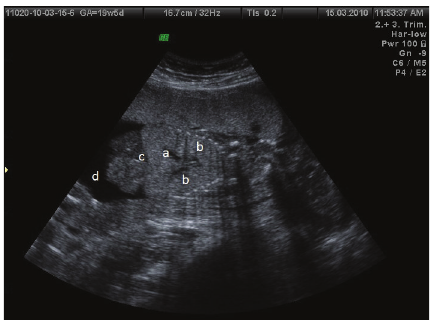
Figure 1: Antenatal sonography of case 1 showing dilated main bronchi(a),largehyperechoiclungs(b),inverteddiaphragm(c),and ascites (d).